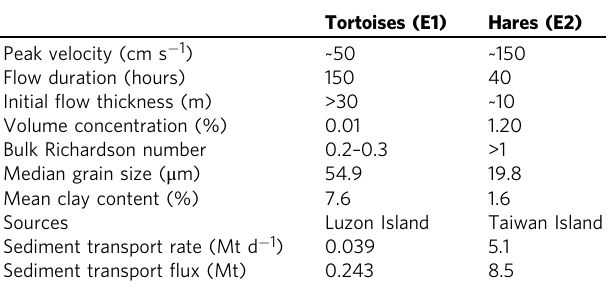
Table 1 Key parameters of the two turbidity